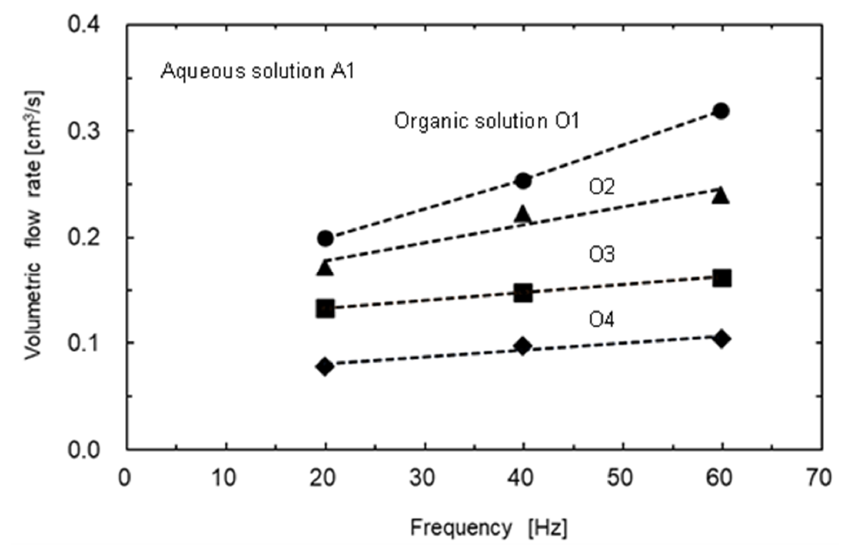
Figure 3. Effect of frequency on volumetric flow rate under various kinematic viscosities of oil phase.